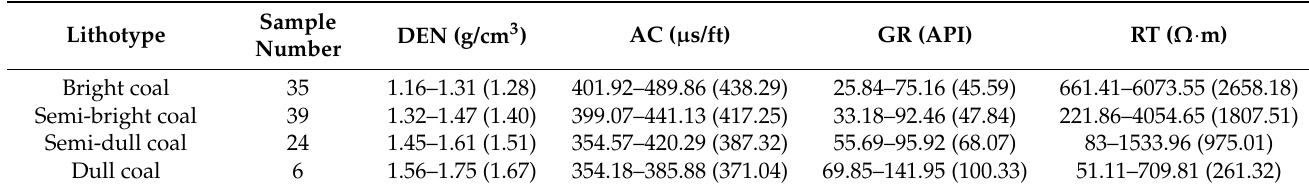
Table 1. Well logging responses of